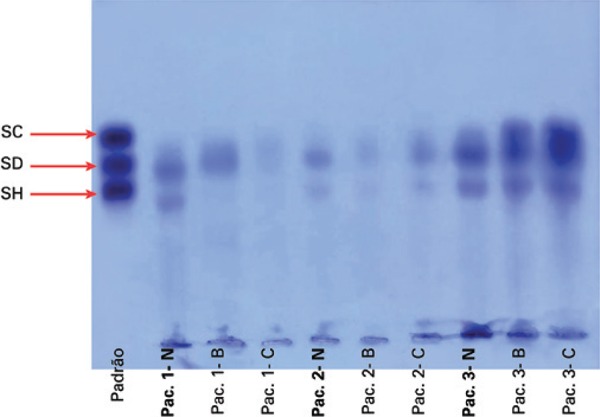
Eletroforese de glicosaminoglicano sulfatado de tecidos colorretais (5µg cada)